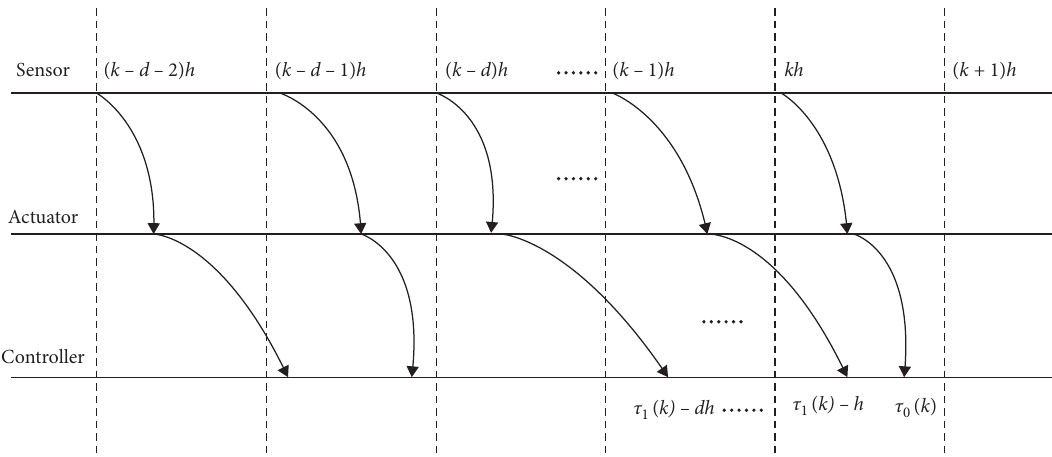
Figure 1: Schematic diagram of data packet